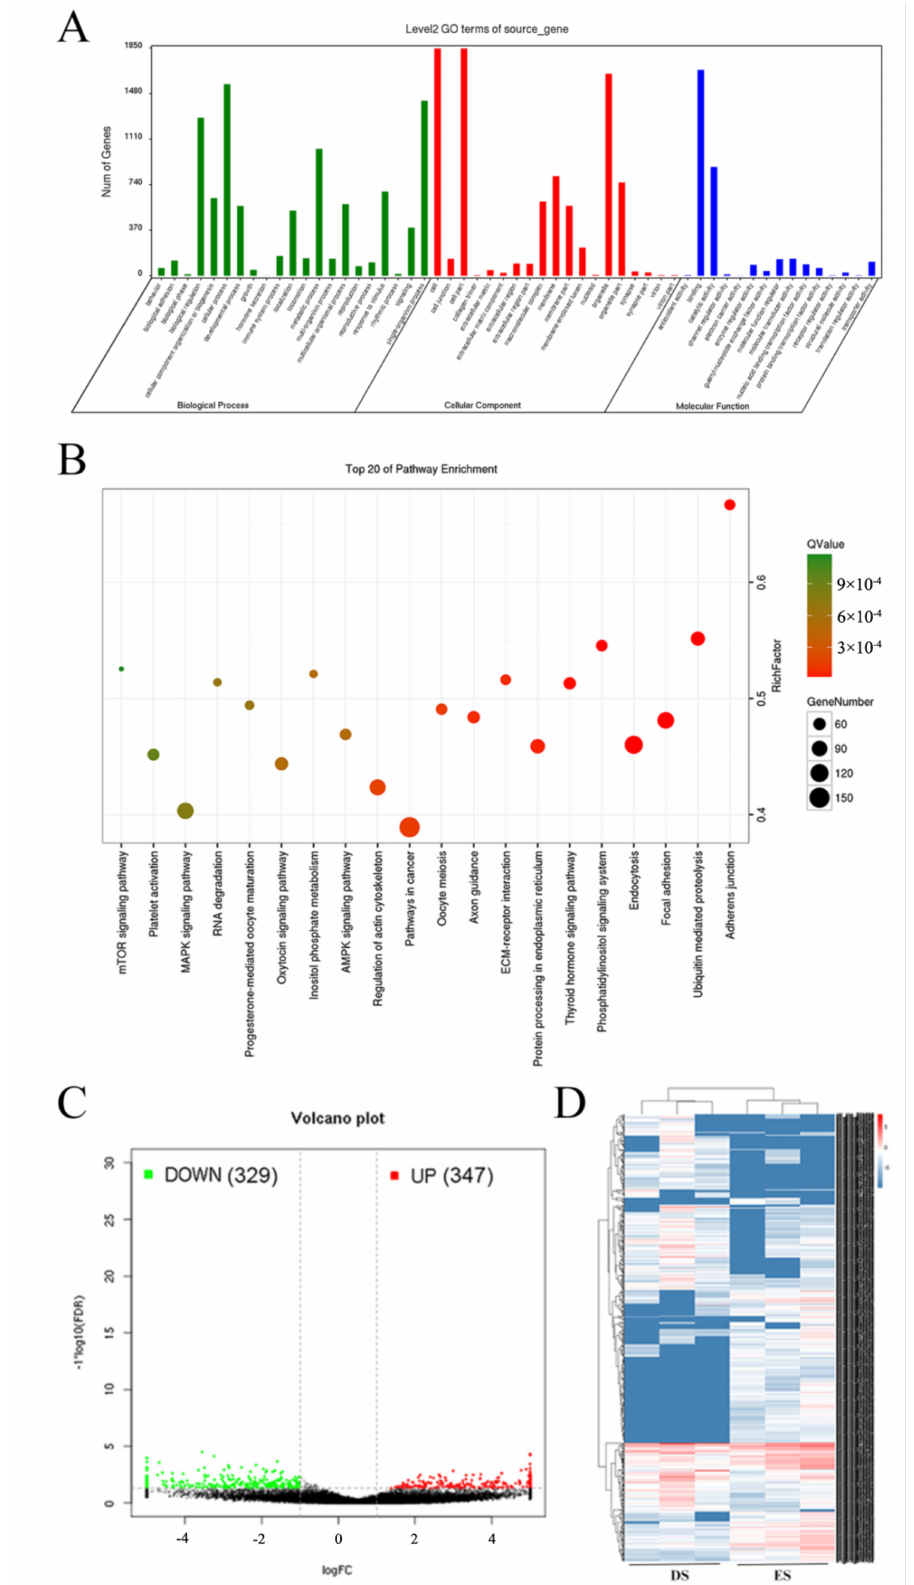
Figure 2. The analysis of circRNA source genes. ( A ) The enriched GO terms of circRNA source genes. GO enrichment of circRNA source genes was conducted to annotate the genes that were potentially spliced to circRNAs in goat ovary. Overall, 9566 of the source genes played roles in biological